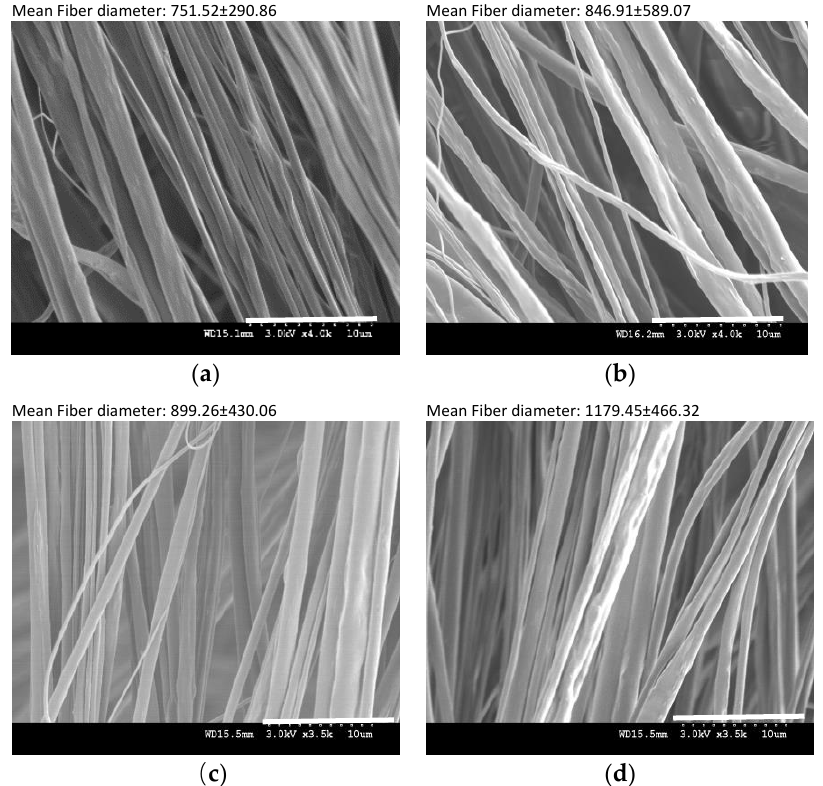
Figure 9. The effect of the GO contents on the mean fiber diameter and the uniformity (standard deviation value) of the electrospun fiber from the GO-ASC -g-P(MMA-co-EA nanocomposite: SEM images of ( a ) M1-8; ( b )M1-16; ( c ) M2-8; and, ( d ) M2-16; the scale bar shown on the bottom bar is 10 µm.